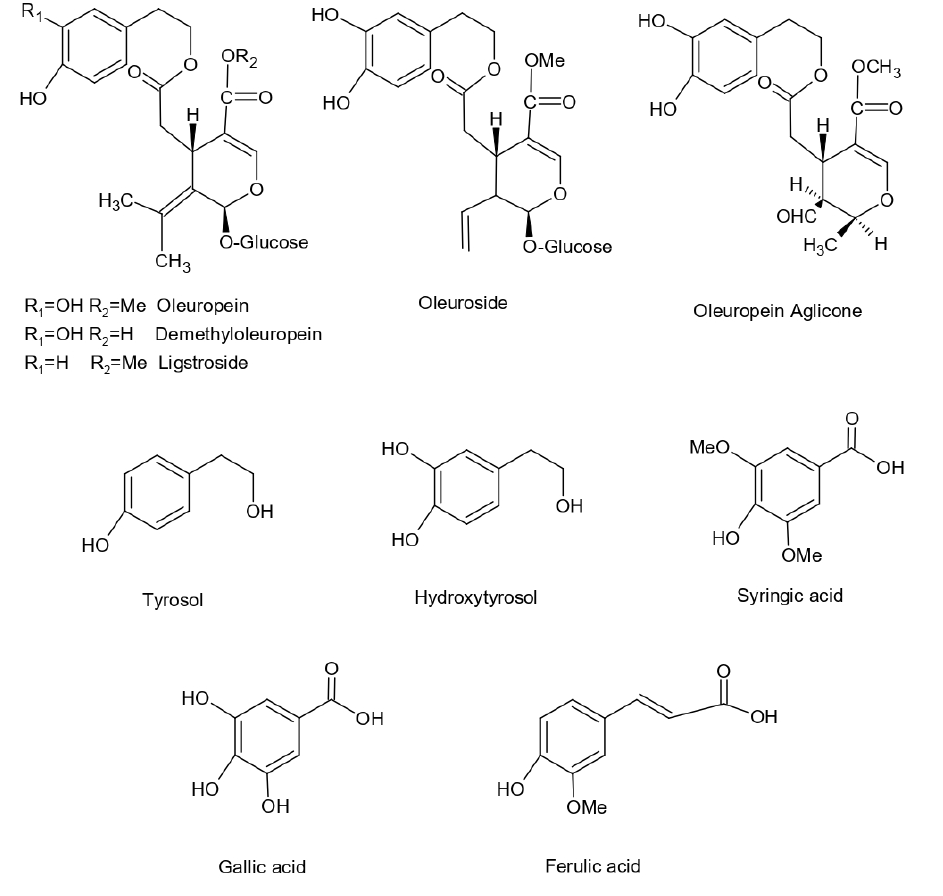
Figure 2. Chemical structures of phenolic compounds already identified in Olea europaea L. leaf extract.